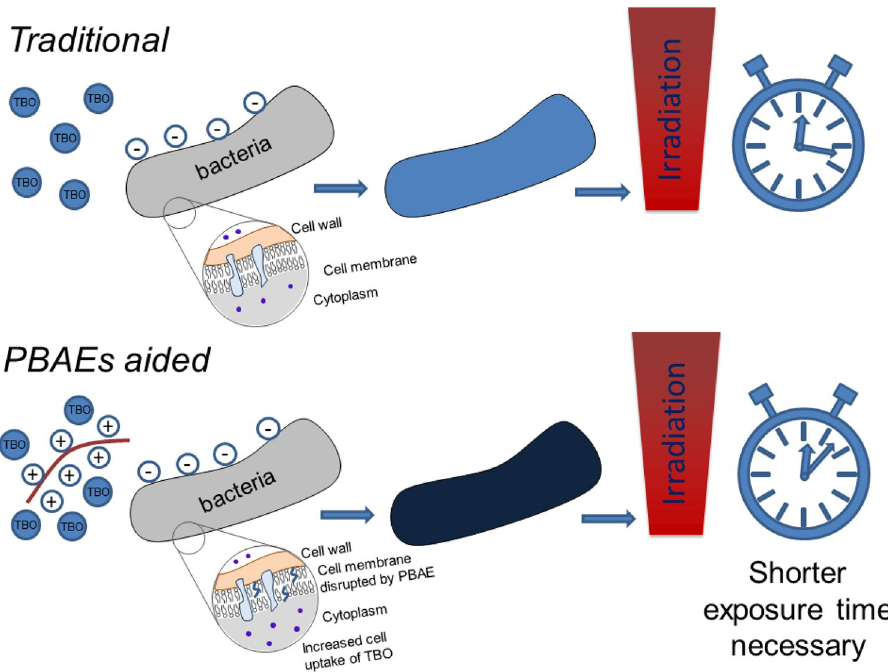
Figure 1. Schematic representation of the mechanism underpinning the enhancement of aPDT efficacy due to